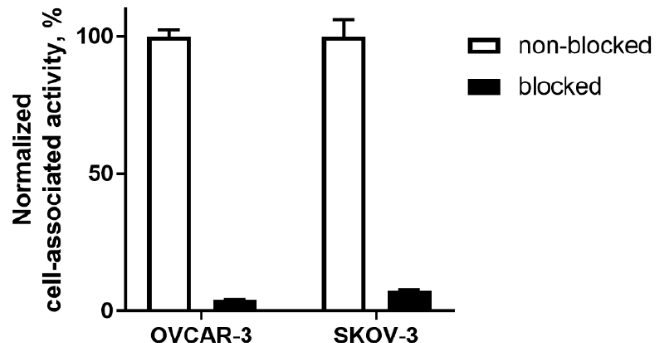
Figure 2. Binding specificity of [ 125 I]I-PIB-Ec1 to epithelial cell adhesion molecule (EpCAM)-expressing OVCAR-3 and SKOV-3 ovarian cancer cells in vitro. For blocking, 100-fold molar excess of non-labeled Ec1 DARPin was added to blocked groups. Final concentration of radiolabeled compound was 2 nM. Data are presented as mean from three samples ± SD.